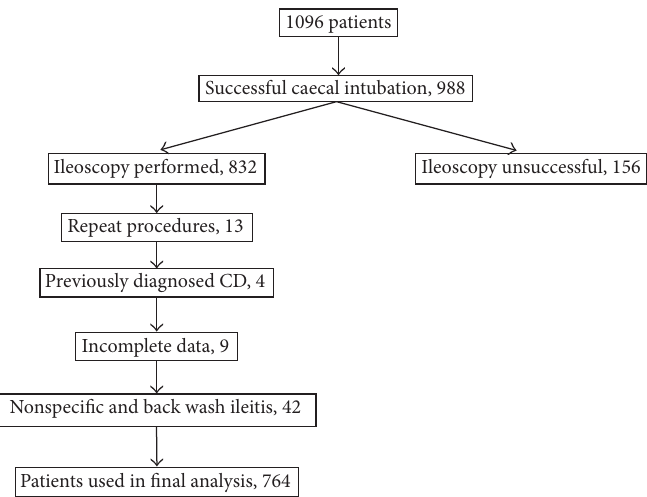
Figure 1: Patient